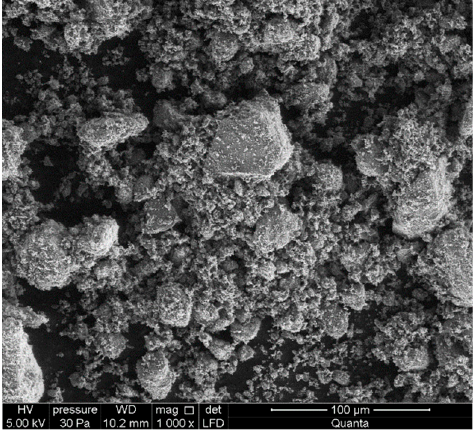
Figure 3. Scanning electron microscope image of the natural zeolite (Quanta FEG 250 SEM).